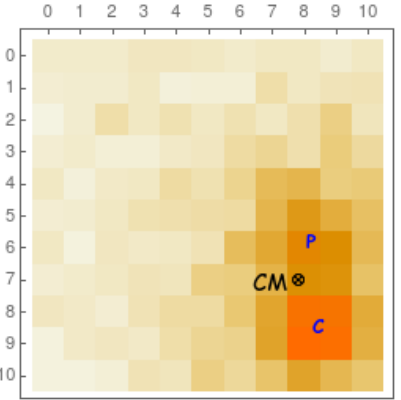
Figure 3. Representation of a 10 × 10 matrix of 1 × 1 mm 2 pixels (coupled to a scintillating crystal as in Figure 2, but with a smaller size) for a typical event with a Compton interaction (C) previous to a photoelectric absorption (P). The electronic readout normally associates the coordinates of this gamma ray event to the center of mass of the energy distribution (CM). Higher-intensity colors correspond to a higher number of detected optical